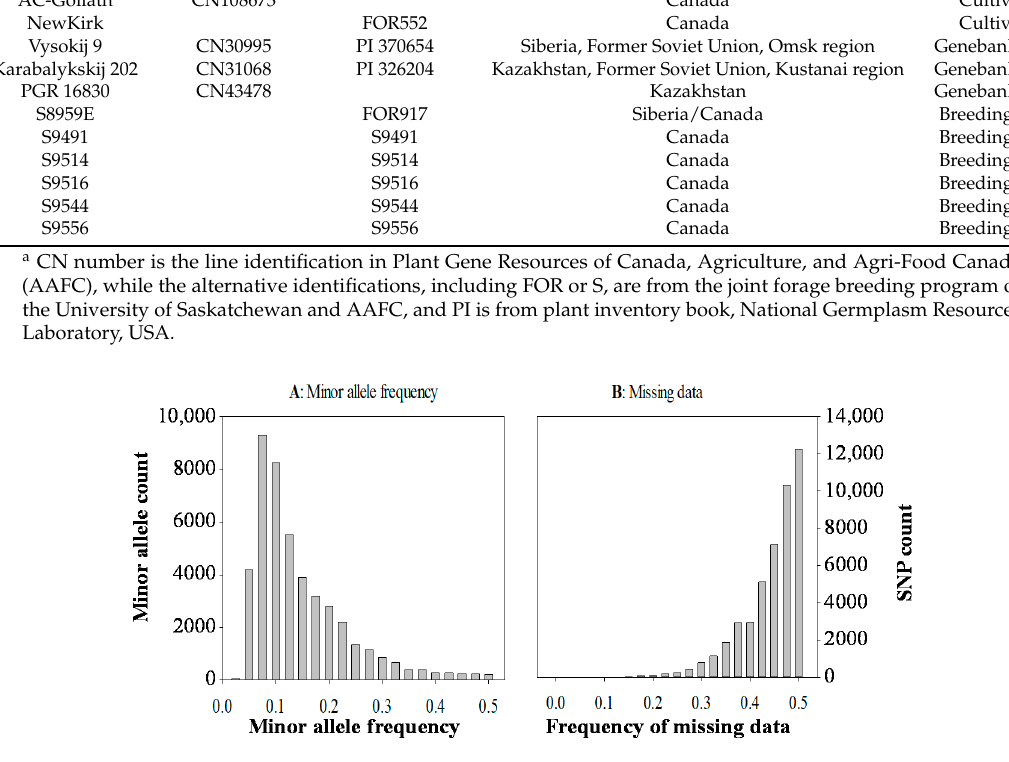
Figure 1. The minor allele frequency distribution ( A ) and the frequency of missing data ( B ) for 45,507 SNP markers in 192 genotypes of 12 crested wheatgrass lines.